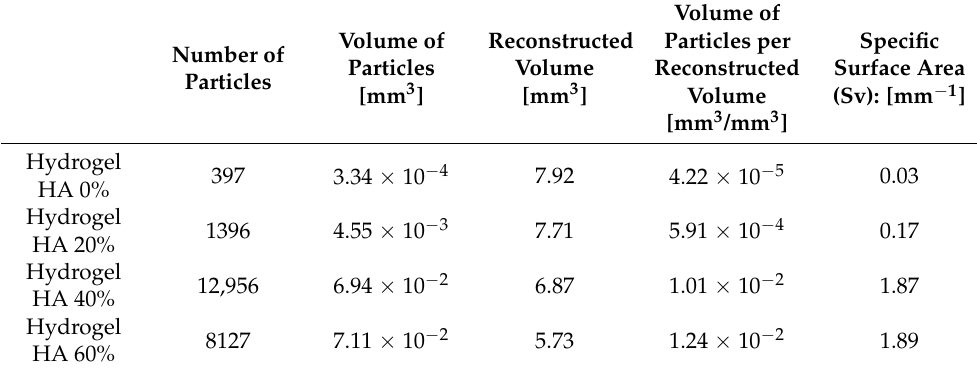
Table 5. Differing HA percentage contents in the SA hydrogels, in terms of the number of particles, the volume of particles, reconstructed volumes, the volume of particles per reconstructed volume, and specific surface area